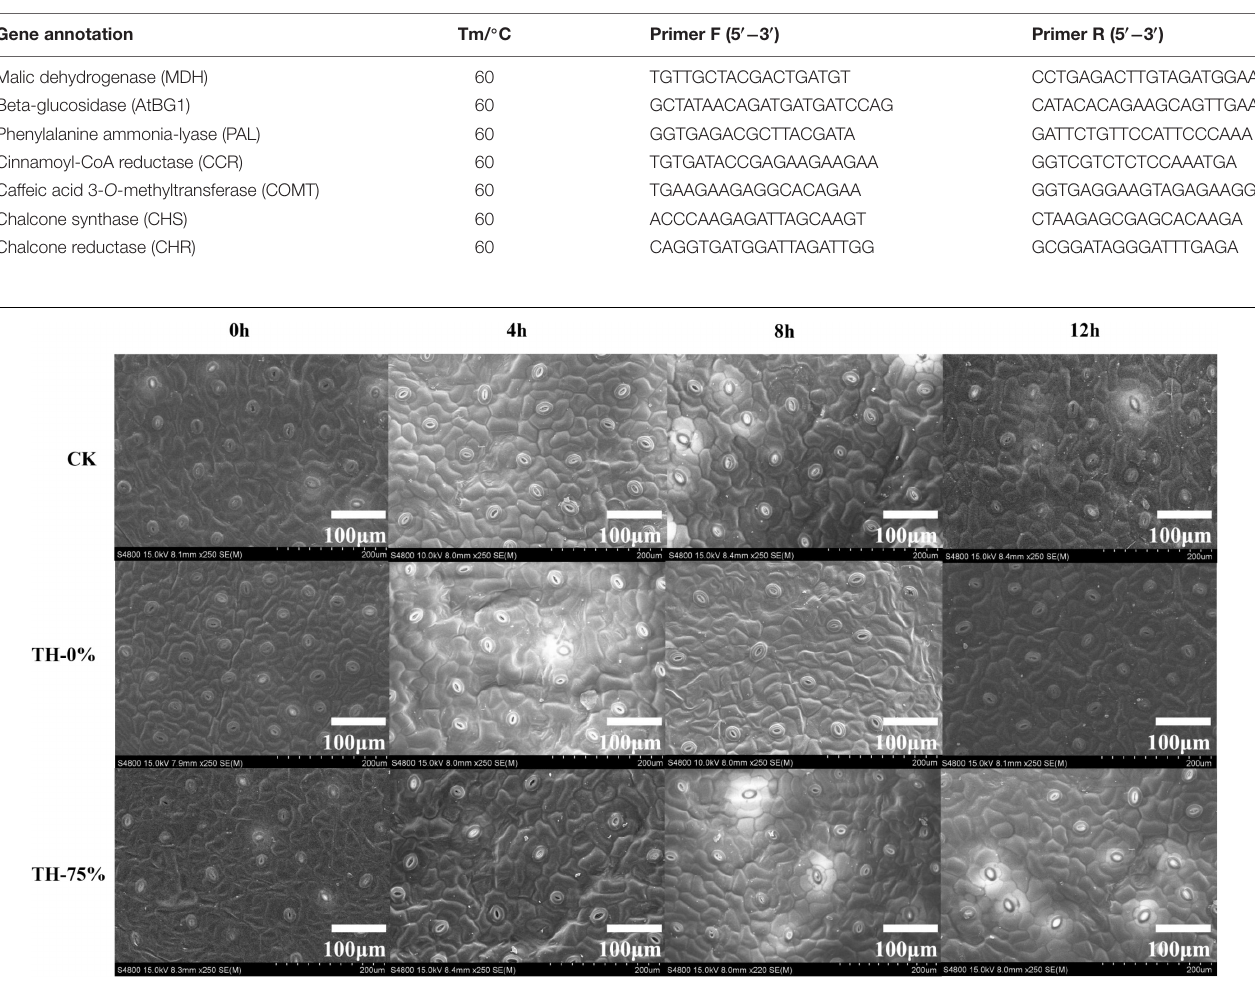
FIGURE 1 | The scanning electron microscopy of leaf surfaces in CK, TH-0%, and TH-75% at 0, 4, 8, and 12